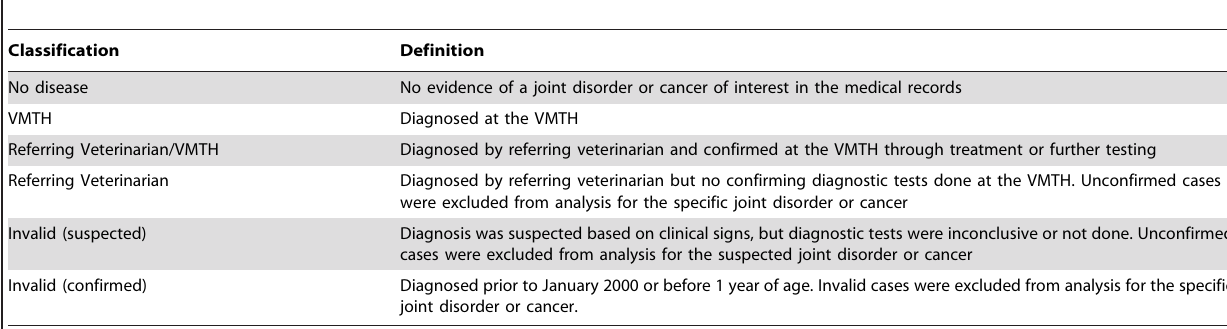
Table 1. Categories used in determining diagnosis for joint disorders and cancers of interest in Golden Retrievers and Labrador Retrievers (1–8 years old) admitted to the Veterinary Medical Hospital, University of California, Davis, from